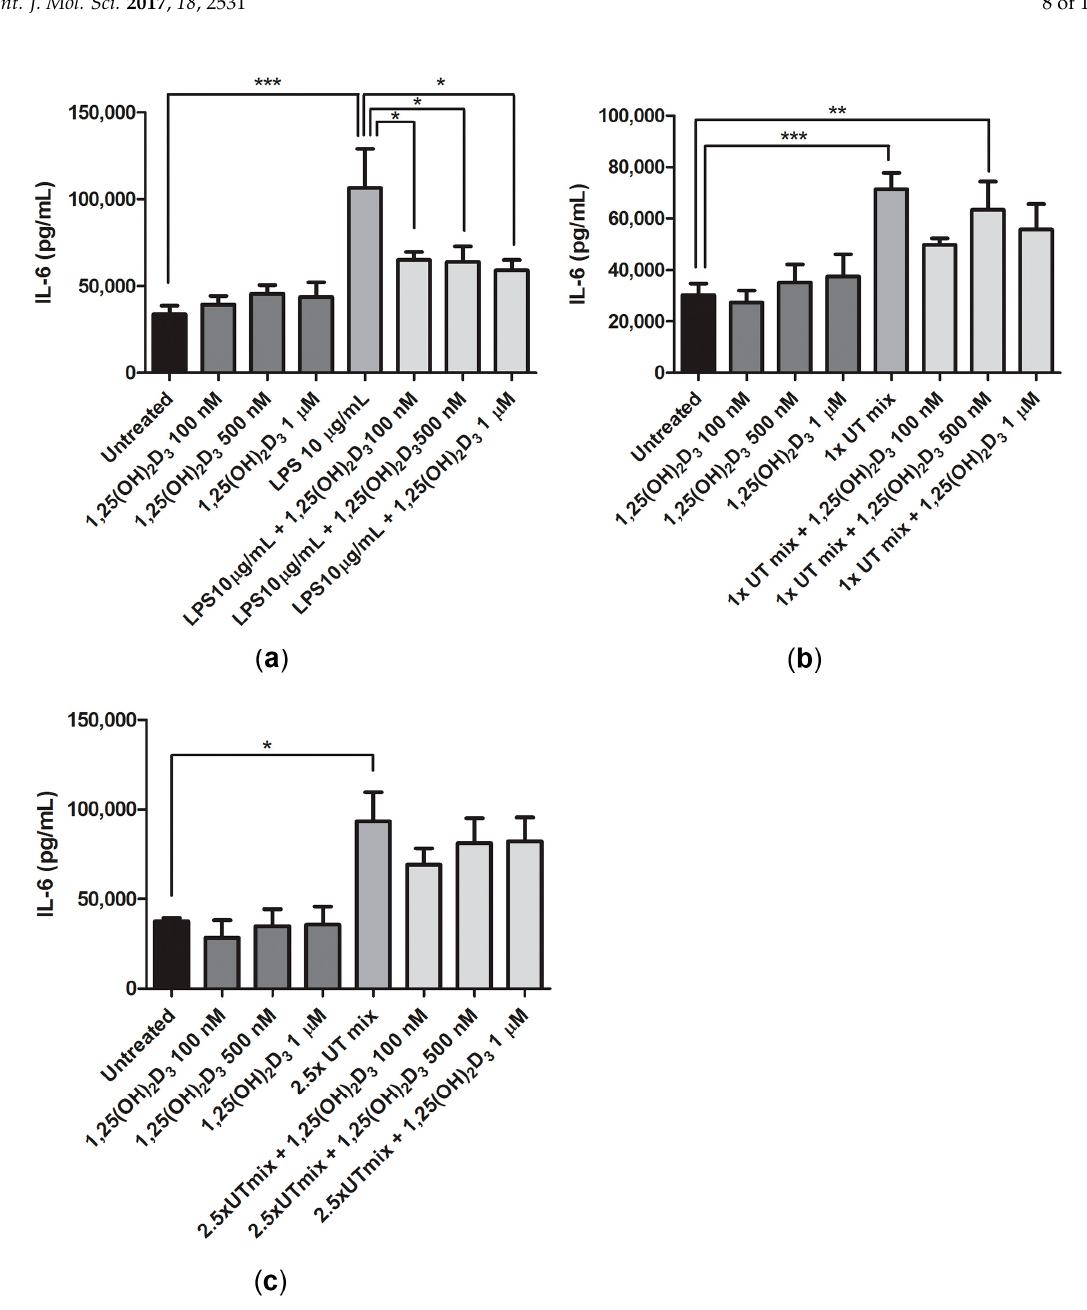
Figure 5. Vitamin D effect on IL-6 release by ciPTEC-OAT1 in inflammatory and uremic conditions. IL-6 release in cell culture supernatants after 24 h exposure to ( a ) 1,25(OH) 2 D 3 (100 nM, 500 nM and 1 µ M), LPS (10 µ g/mL) and combination of the two, ( b ) 1,25(OH) 2 D 3 (100 nM, 500 nM and 1 µ M), 1 × UT mix and combination of the two, ( c ) 1,25(OH) 2 D 3 (100 nM, 500 nM and 1 µ M), 2.5 × UT mix and their combination. Concentration expressed as pg/mL (mean ± SEM). At least three independent experiments were performed. * p < 0.05, ** p < 0.01, *** p < 0.001 (One-way ANOVA followed by Dunnett’s multiple comparison test, using as a control either untreated sample, LPS 10 µ g/mL, 1 × UT mix or 2.5 × UT mix, as indicated).